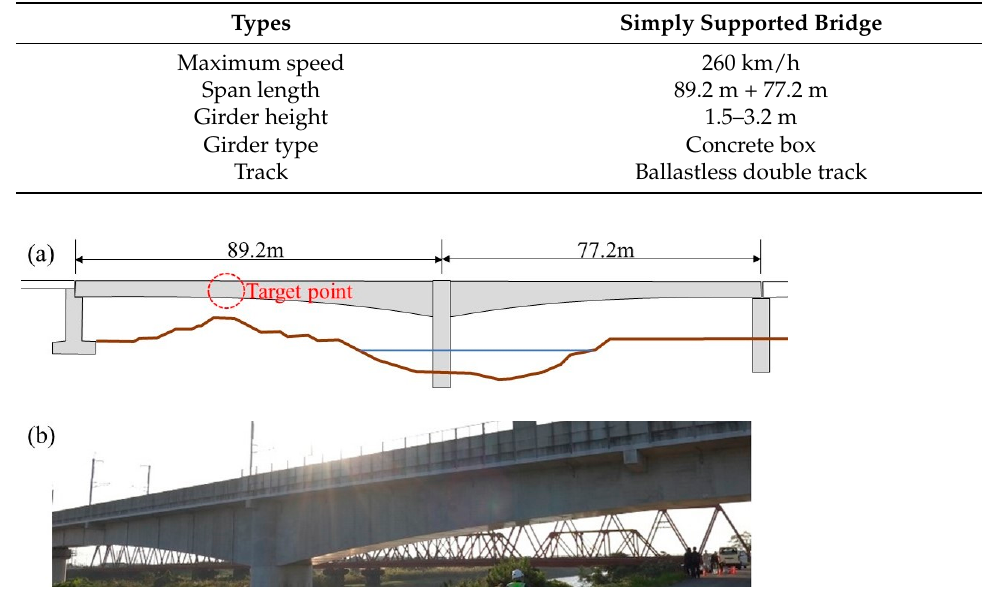
Figure 6. Outline of bridge B: ( a ) bridge span and sketch, ( b ) view of bridge A.